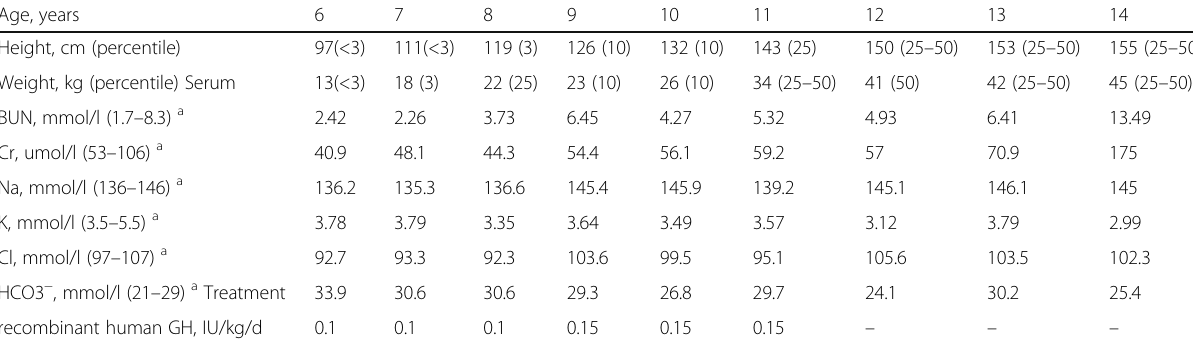
Table 1 Clinical and laboratory data and treatment of the patient during follow-up Age,